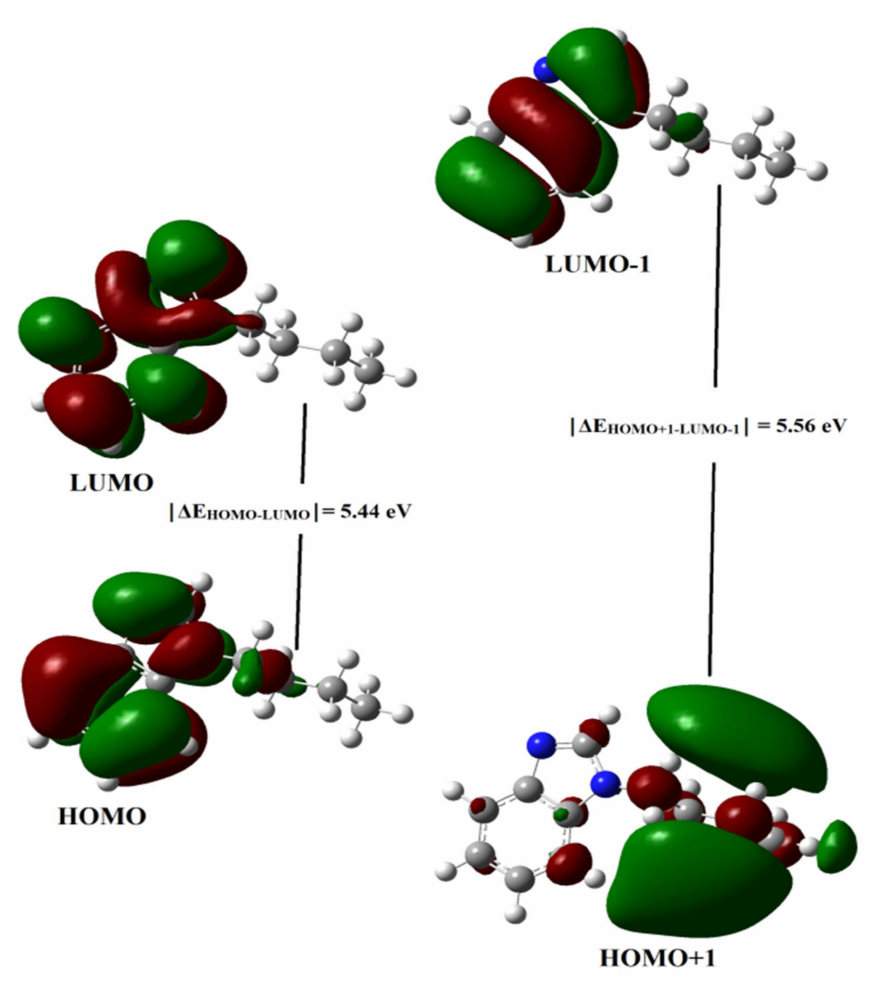
Figure 7. Frontier molecular orbital (HOMO-LUMO) image of the title